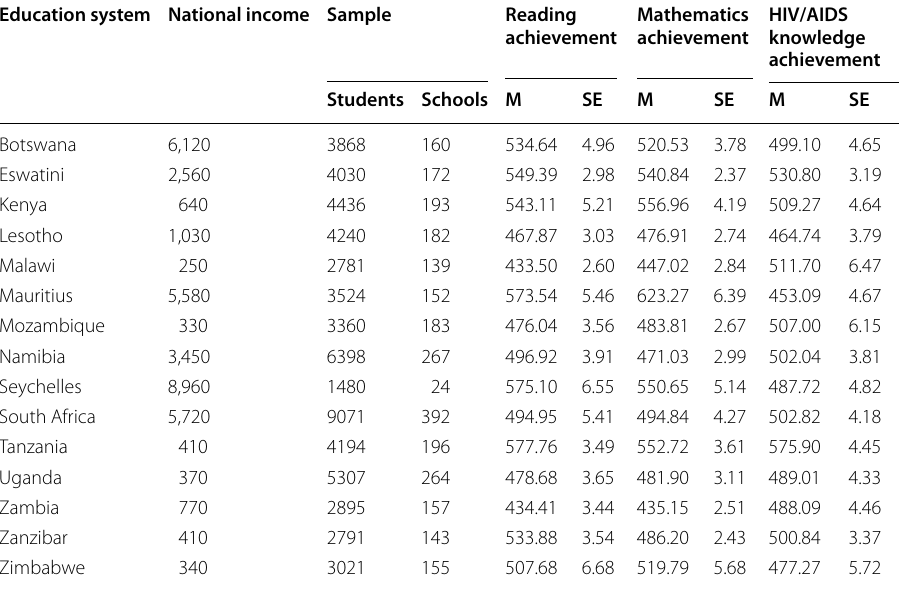
Table 1 Education system characteristics and achievement descriptive statistics